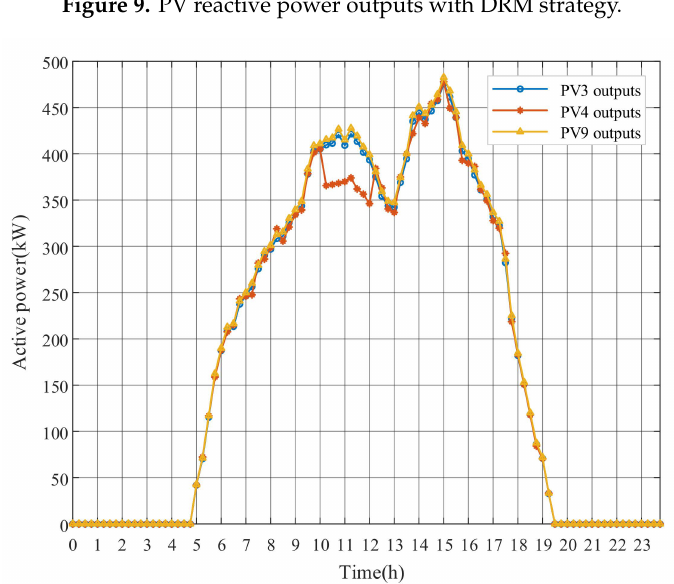
Figure 10. PV active power outputs with DRM